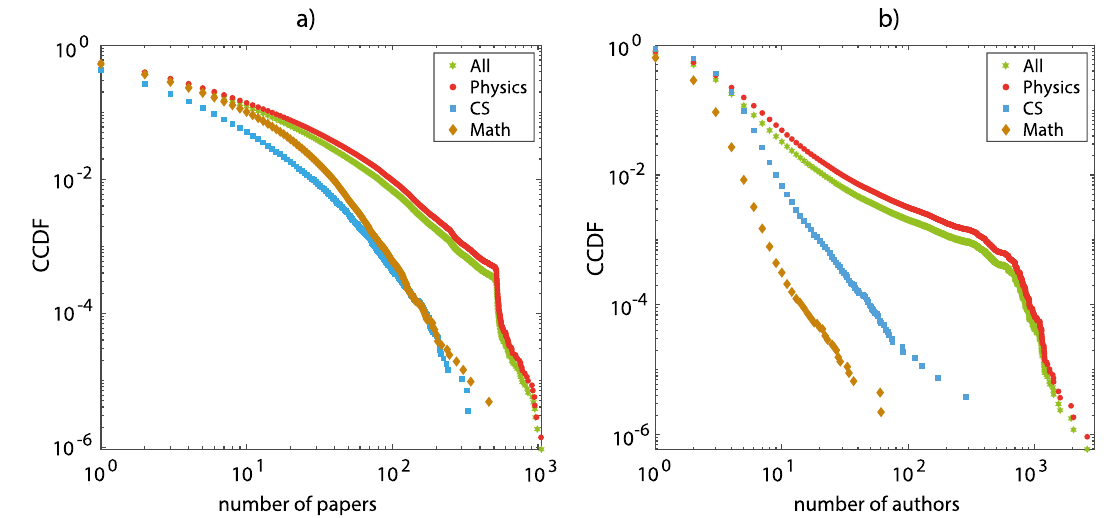
Figure 2. (a) Complementary cumulative distribution functions (CCDF, see text for definition) for the primal graphs obtained from the data-set. The distributions are functions of the nodes’ degree distributions for H ( H phys , H math , H cs ) and of hyperedges’ degree distributions for the respective dual hypergraphs. (b) CCDF for the dual graphs, which are functions of the hyperedges’ degree distribution in H ( H phys , H math , H cs ) and of the nodes degree distribution in the respective dual hypergraphs. Curves are coloured according to the different speciality from which papers are extracted from the data-set (see the colour code at the top right of each